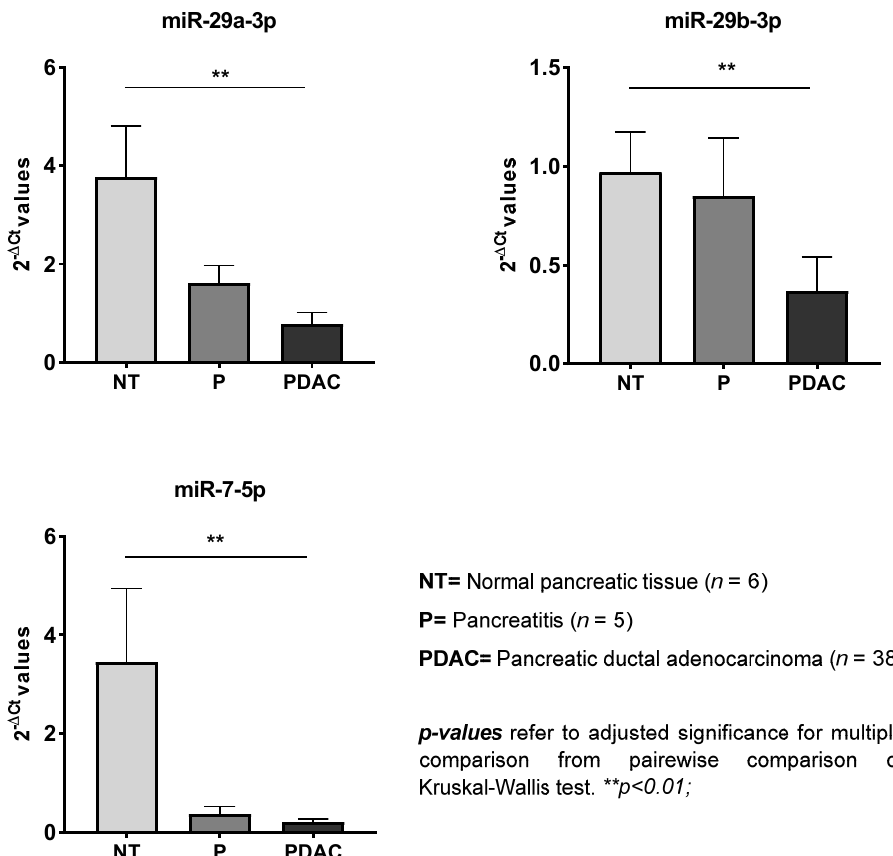
Figure 2. Differential expression of miRNAs in pancreatic tissues from normal (NT) and pancreatic ductal adenocarcinoma (PDAC) groups. Values are shown as mean ±